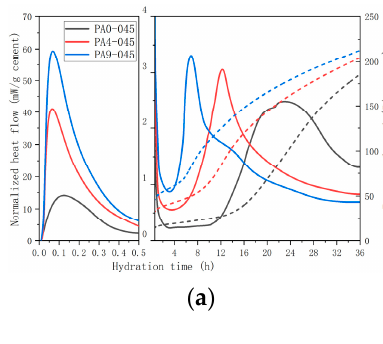
Figure 5. Curves of isothermal calorimetry for AS accelerator cement paste: ( a ) samples with different doses of the AS accelerator. Sample with a fixed w/c of 0.45 contained 0%, 4%, and 9% AS accelerator, respectively; ( b ) samples with different w/c. Sample with a fixed AS accelerator of 9% contained 0.40, 0.45, and 0.50 w/c, respectively.